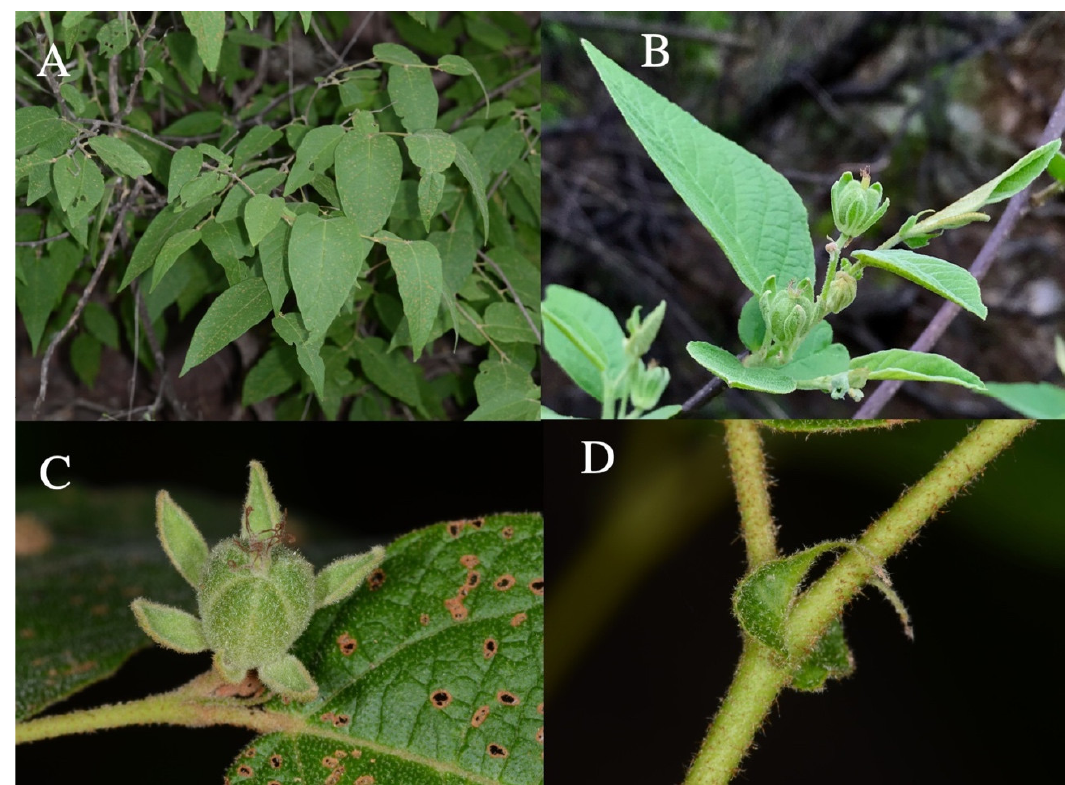
Figure A2. Croton alamosanus. ( A ) Leafy branches. ( B ) Branch with pistillate flowers. ( C ) Young fruit. ( D ) Stipules.